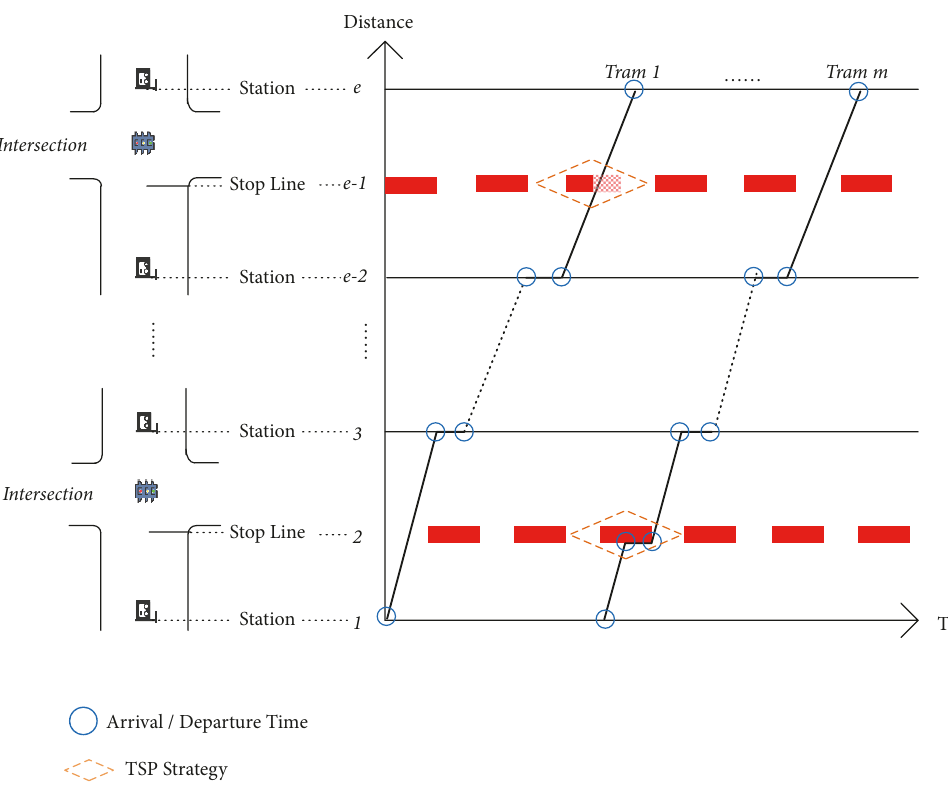
Figure 2: Integrated optimization on signal priority and tram